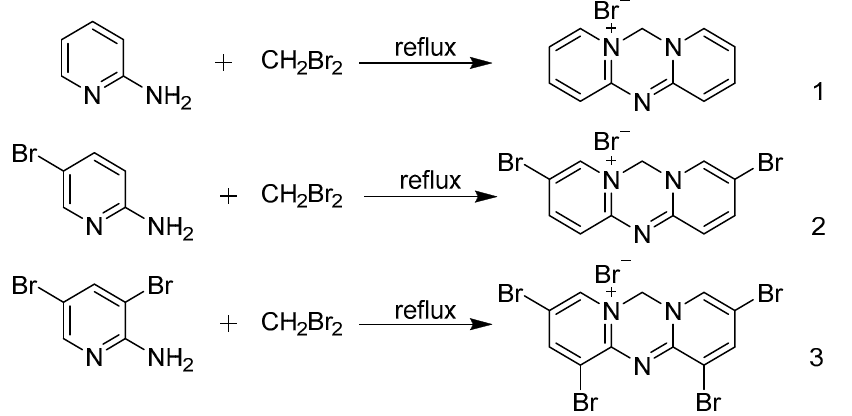
Figure 1. Schematic diagram of reaction between 2-aminopyridine derivatives and dibromo- methane; the aminopyridine and various types of bromopyridine derivatives were used as reactants for synthesis of (1) Azacyanine 1, (2) Azacyanine 2, and (3) Azacyanine 3, under the reflux condition with the dibromomethane used as catalysis agent and solution.